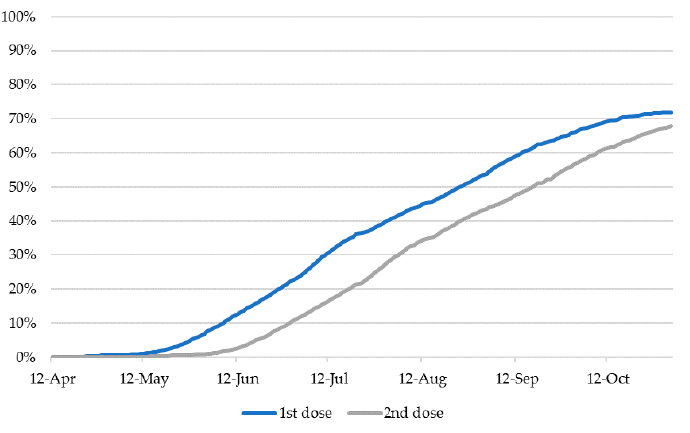
Figure 1. Vaccination rate in Japan.